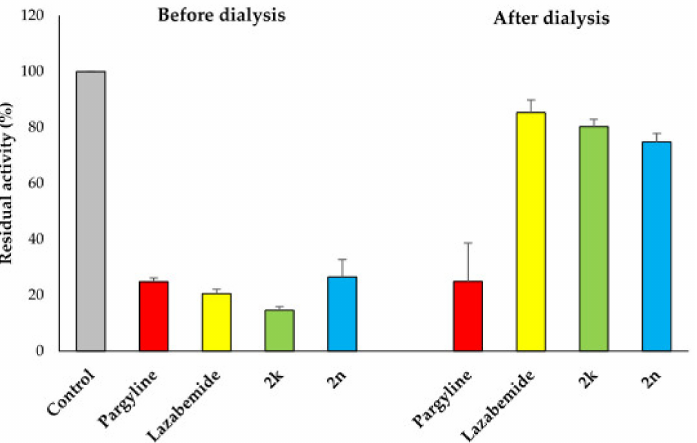
Figure 6. Reversibility tests of 2k and 2n for MAO-B using dialysis method. MAO-B was treated with ~2 × IC 50 of pargyline (0.28 µ M), lazabemide (0.22 µ M), 2k (1.16 µ M), and 2n (2.54 µ M) before dialysis for 6 h. The residual activities were determined before and after dialysis to confirm the reversibility pattern using enzyme assay described in Materials and Methods.